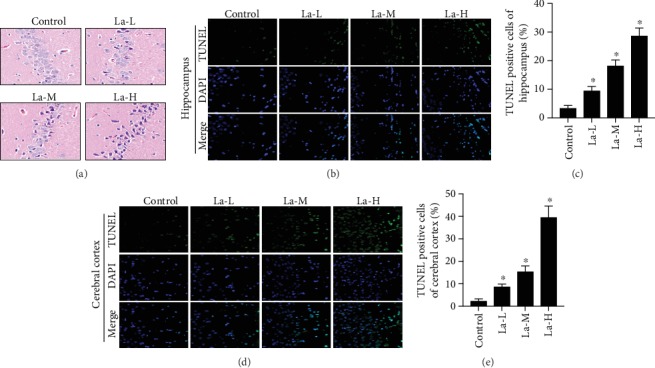
La exposure impaired the synaptic structure of hippocampal neurons and increased neuronal apoptosis in the offspring of treated rats. (a) H&E staining (scale bar = 50 μm); (b) TUNEL assay of the hippocampus (scale bar = 50 μm); (c) quantification of the TUNEL assay in the hippocampus; (d) TUNEL assay of the cortex (scale bar = 50 μm); (e) quantification of the TUNEL assay in the cortex; ∗P < 0.05 compared with the control group.